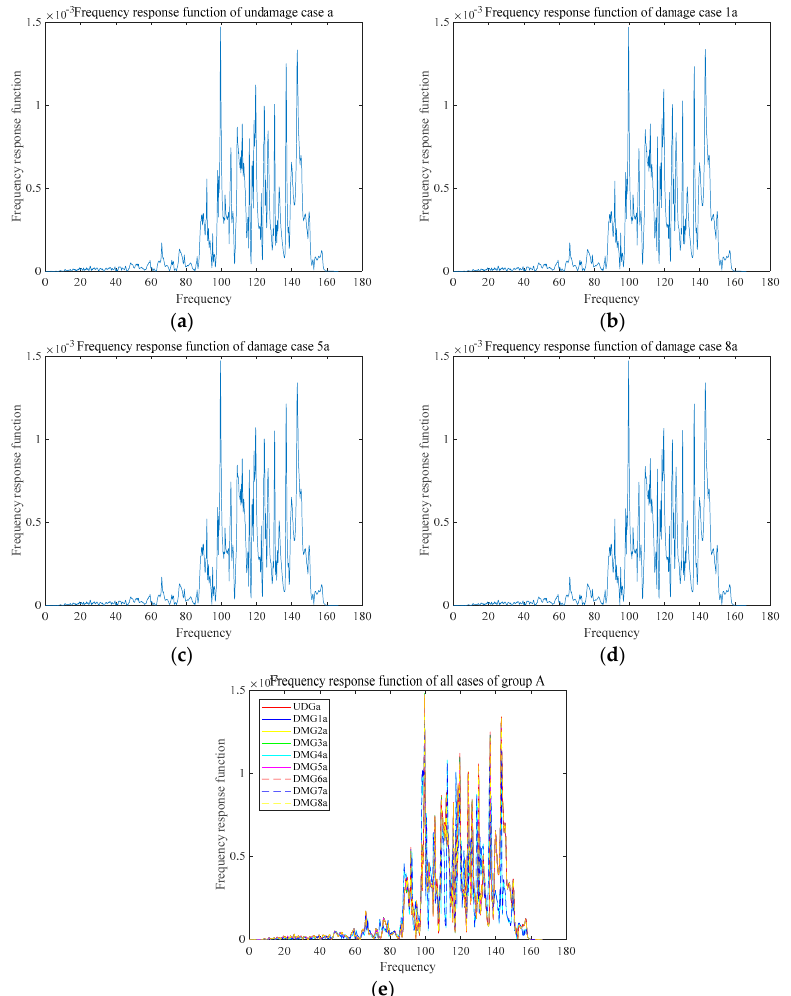
Figure 12. Acceleration frequency response of Group B. ( a ) UDMb; ( c ) DMG5b; and, ( d ) DMG8b. Sensors 2018 , 18 , x